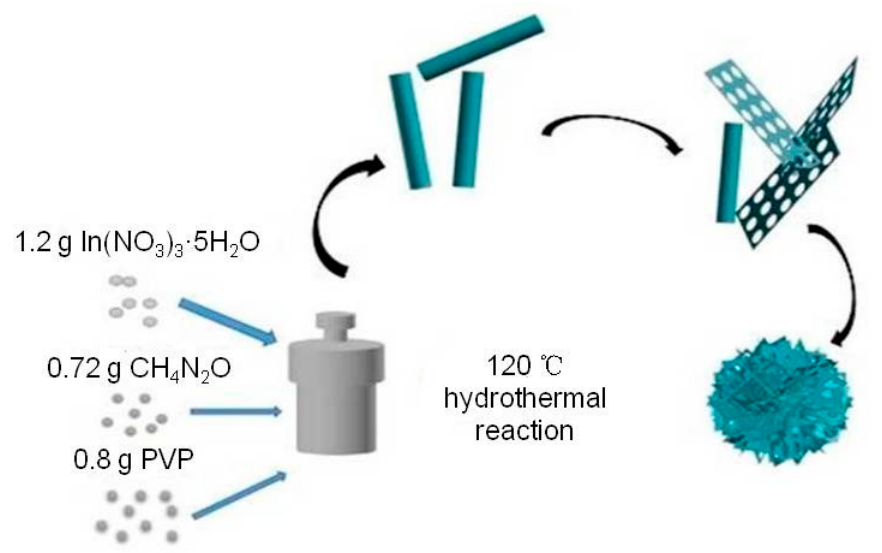
Figure 4. In 2 O 3 flower structure formation mechanism diagram.